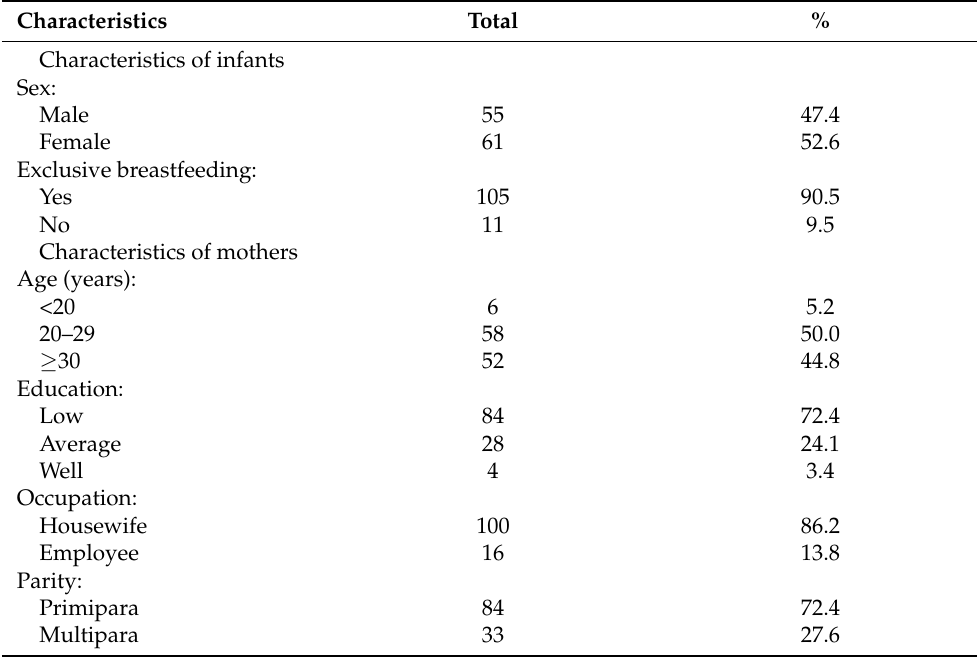
Table 1. General characteristics of infants and mothers ( n =